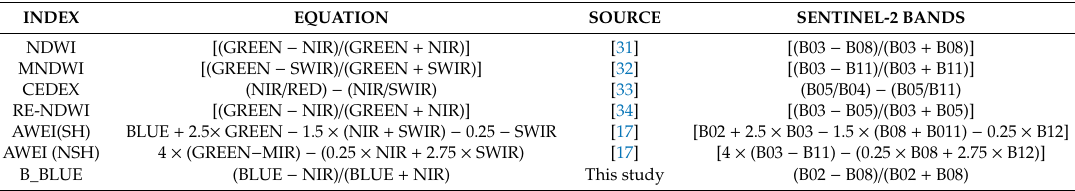
Table 4. Calculated spectral